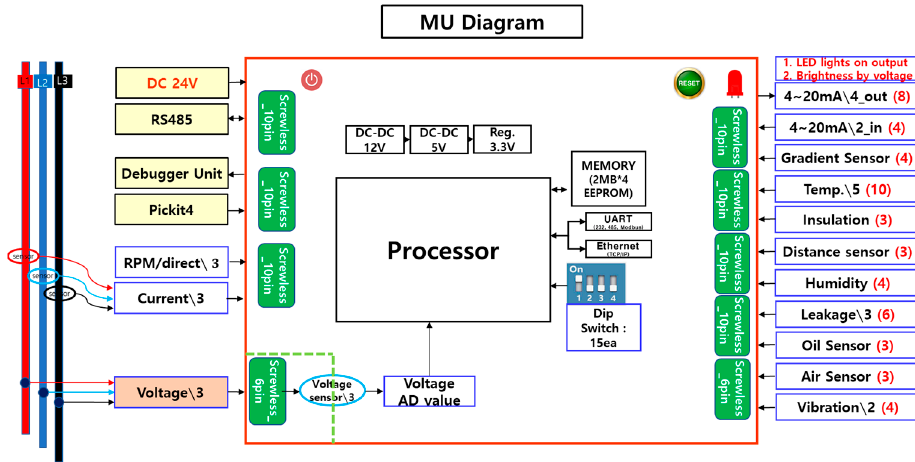
Figure 2. MU block diagram. Figure 2. MU block